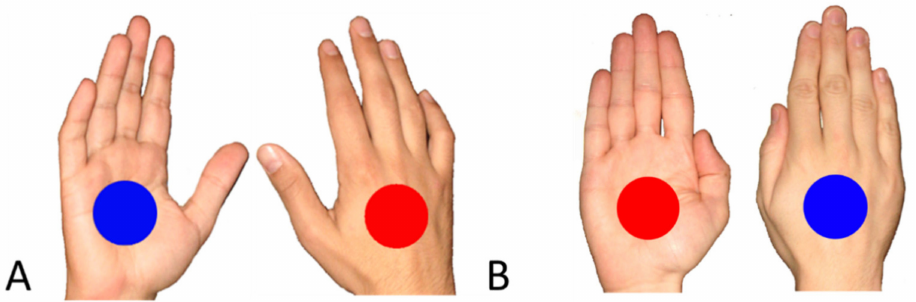
Figure 1. Stimuli used in Experiments 1 ( A , B ) and 2 ( A only) are shown. A total of 120 back-hand views and 120 palm-hand views were shown in two